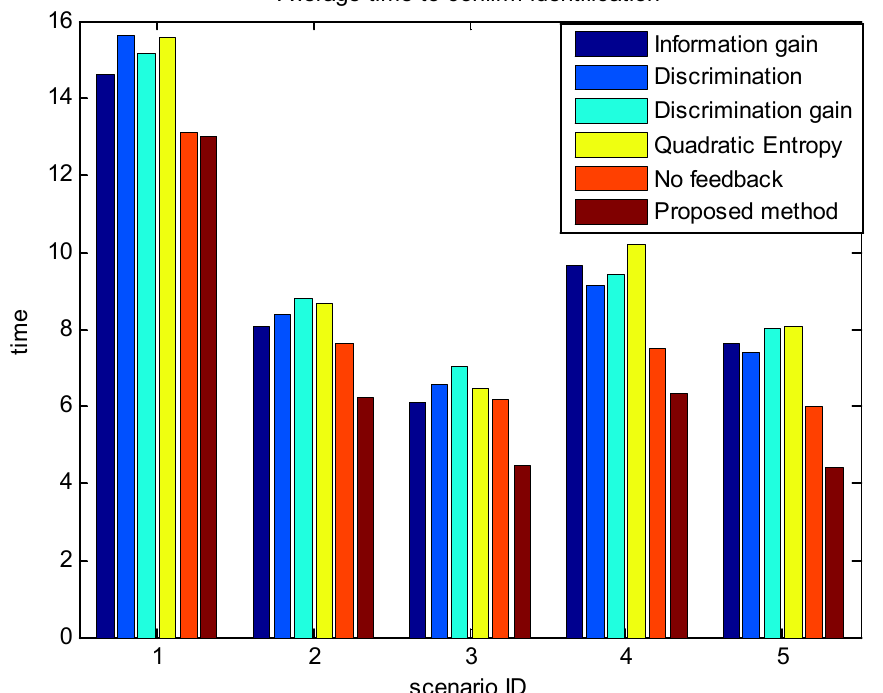
Figure 13. Comparison chart of average confirmation recognition time based on various algorithms under condition 3.